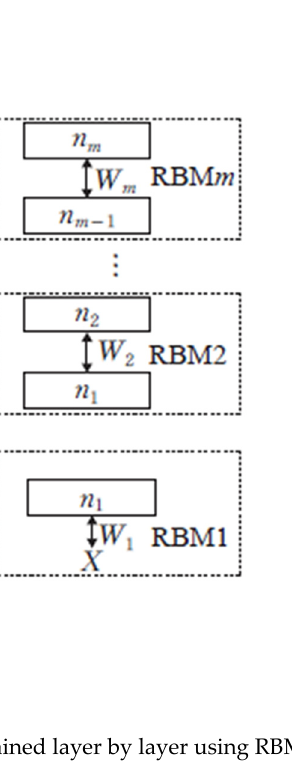
Figure 3. Proposed model based on